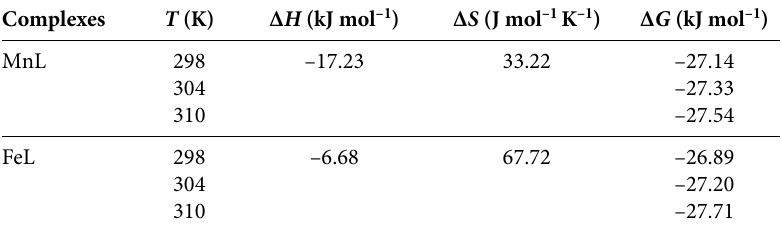
Table 3: Thermodynamic parameters of the binding interaction of metal complexes with BSA Complexes